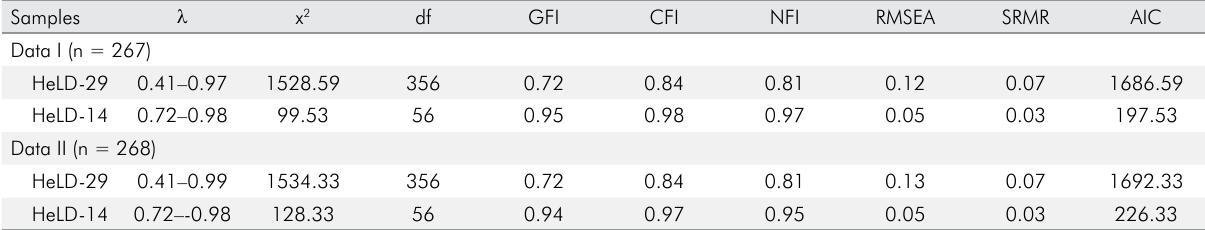
Table 2. Goodness of Fit Indices of Confirmatory Factor Analysis for HeLD-29 and